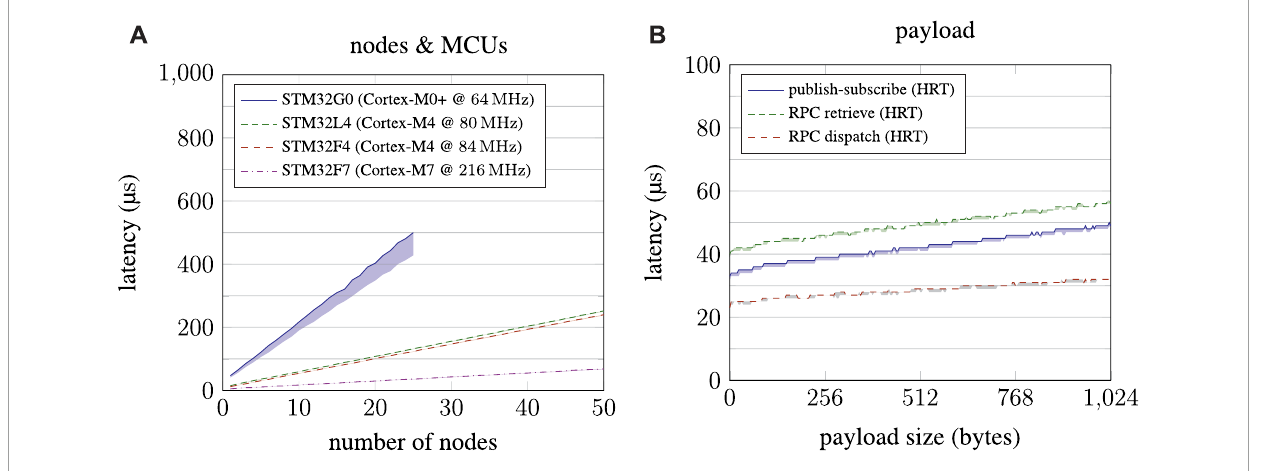
FIGURE 6 General performance measurements of µRT. On the left-hand side (A) , performance scaling when increasing the total number of nodes in a system is depicted, thereby comparing different MCUs. On the right-hand side (B) , the performance impact of payload sizes is shown for both communication schemes supported by µRT.